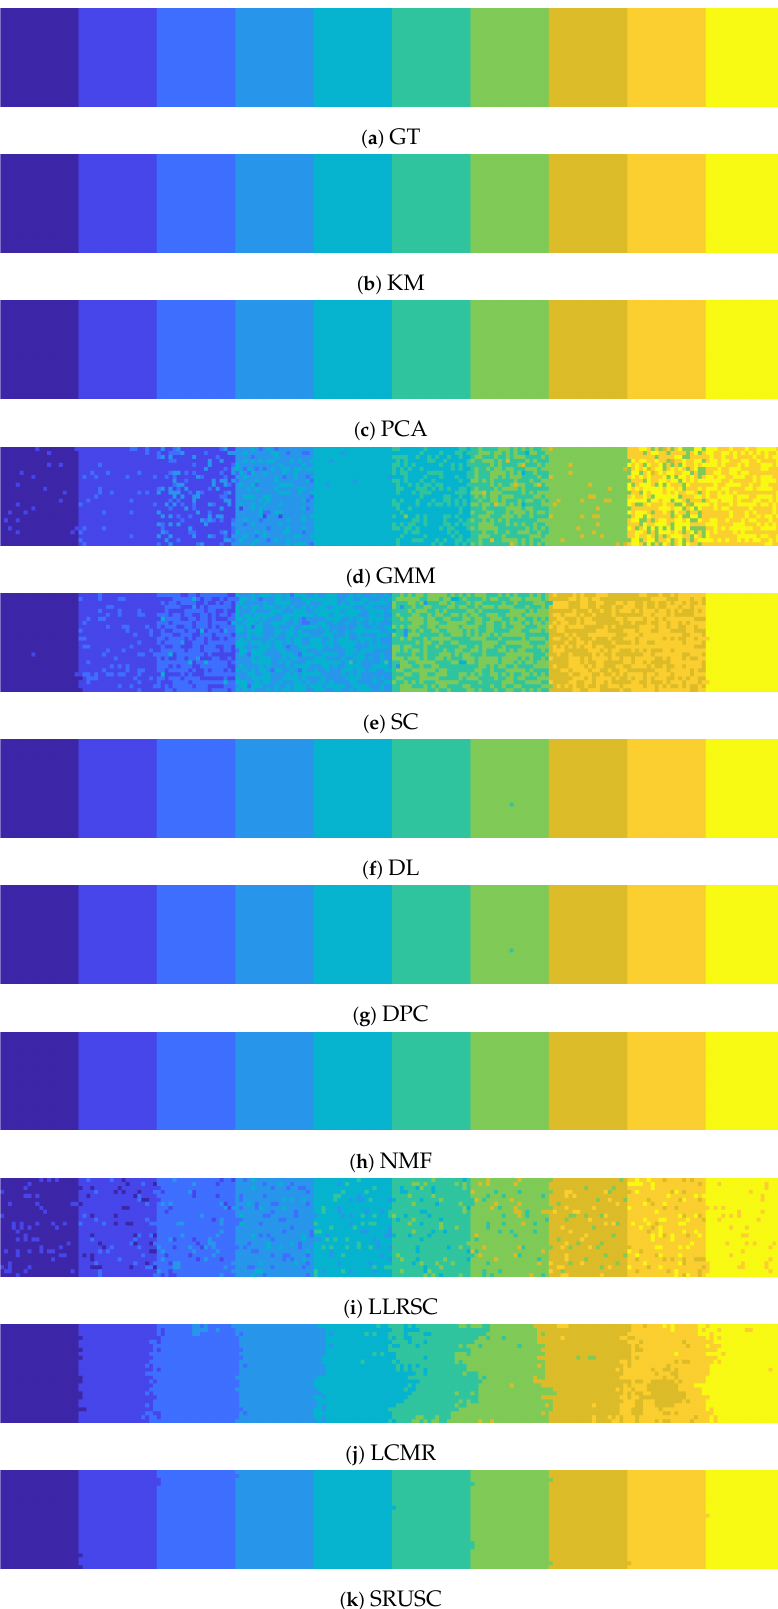
Figure 9. On the synthetic ten Gaussian data set, several models achieve nearly perfect accuracy, including the proposed method. However, both the SC and GMM methods fail to cluster properly. Note that our model only fails on a small number of points on the boundary of two different class, where the spatial information is not